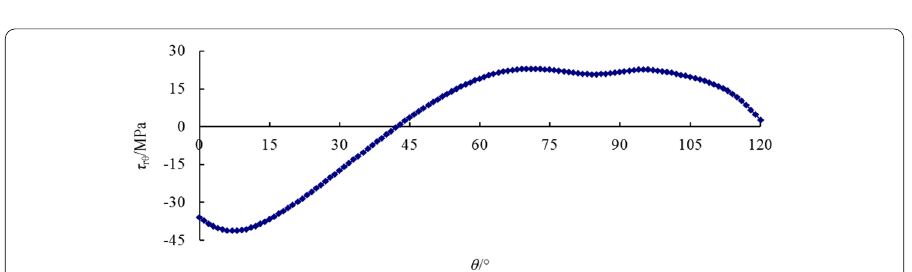
Figure 7 Distribution of shear stress along the middle circumference